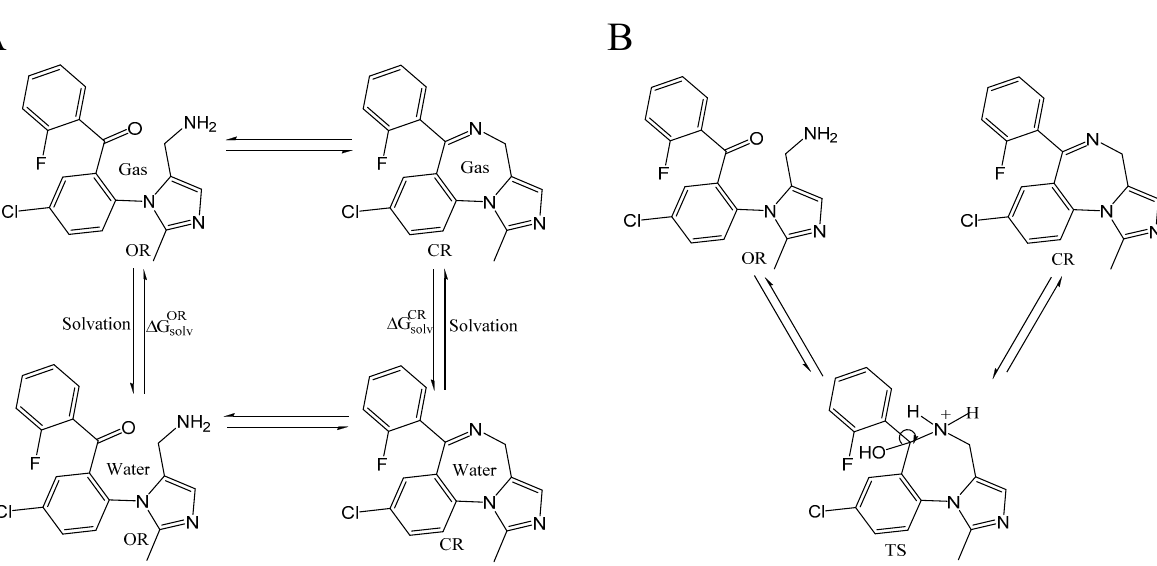
Figure 2. Thermodynamic cycle to evaluate the free energy of solvation ( (cid:1986)(cid:1833) (cid:3046)(cid:3042)(cid:3039)(cid:3049)(cid:3016)(cid:3019) and (cid:1986)(cid:1833) (cid:3046)(cid:3042)(cid:3039)(cid:3049)(cid:3004)(cid:3019) ) for midazolam open-ring (OR) and closed-ring (CR) forms ( A ) and reversible pH-dependent OR-to-CR conversion reaction ( B ) occurring through the formation of the ionized transition state intermediate